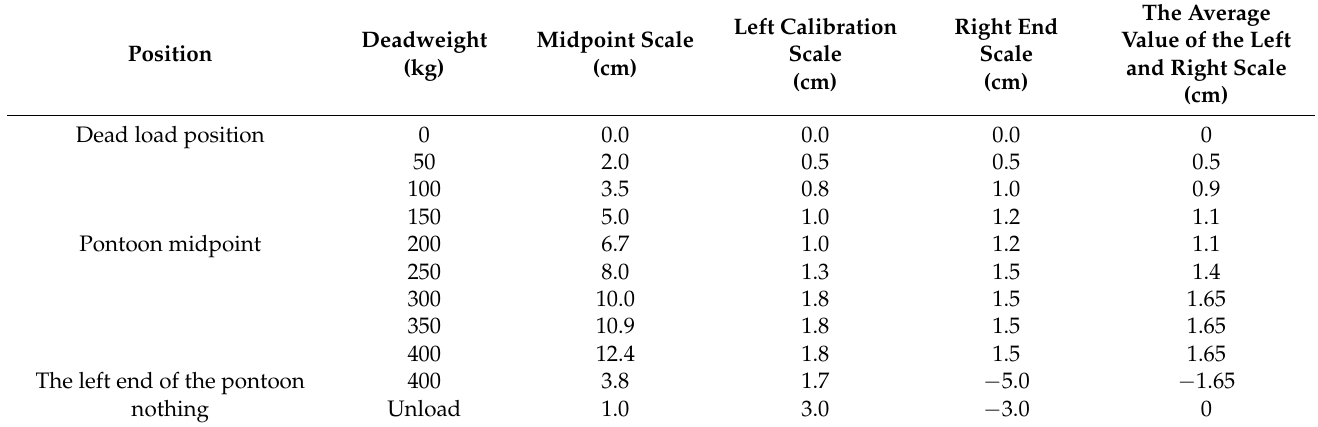
Table 4. Ballast Test with Water Bag pontoon draft record.